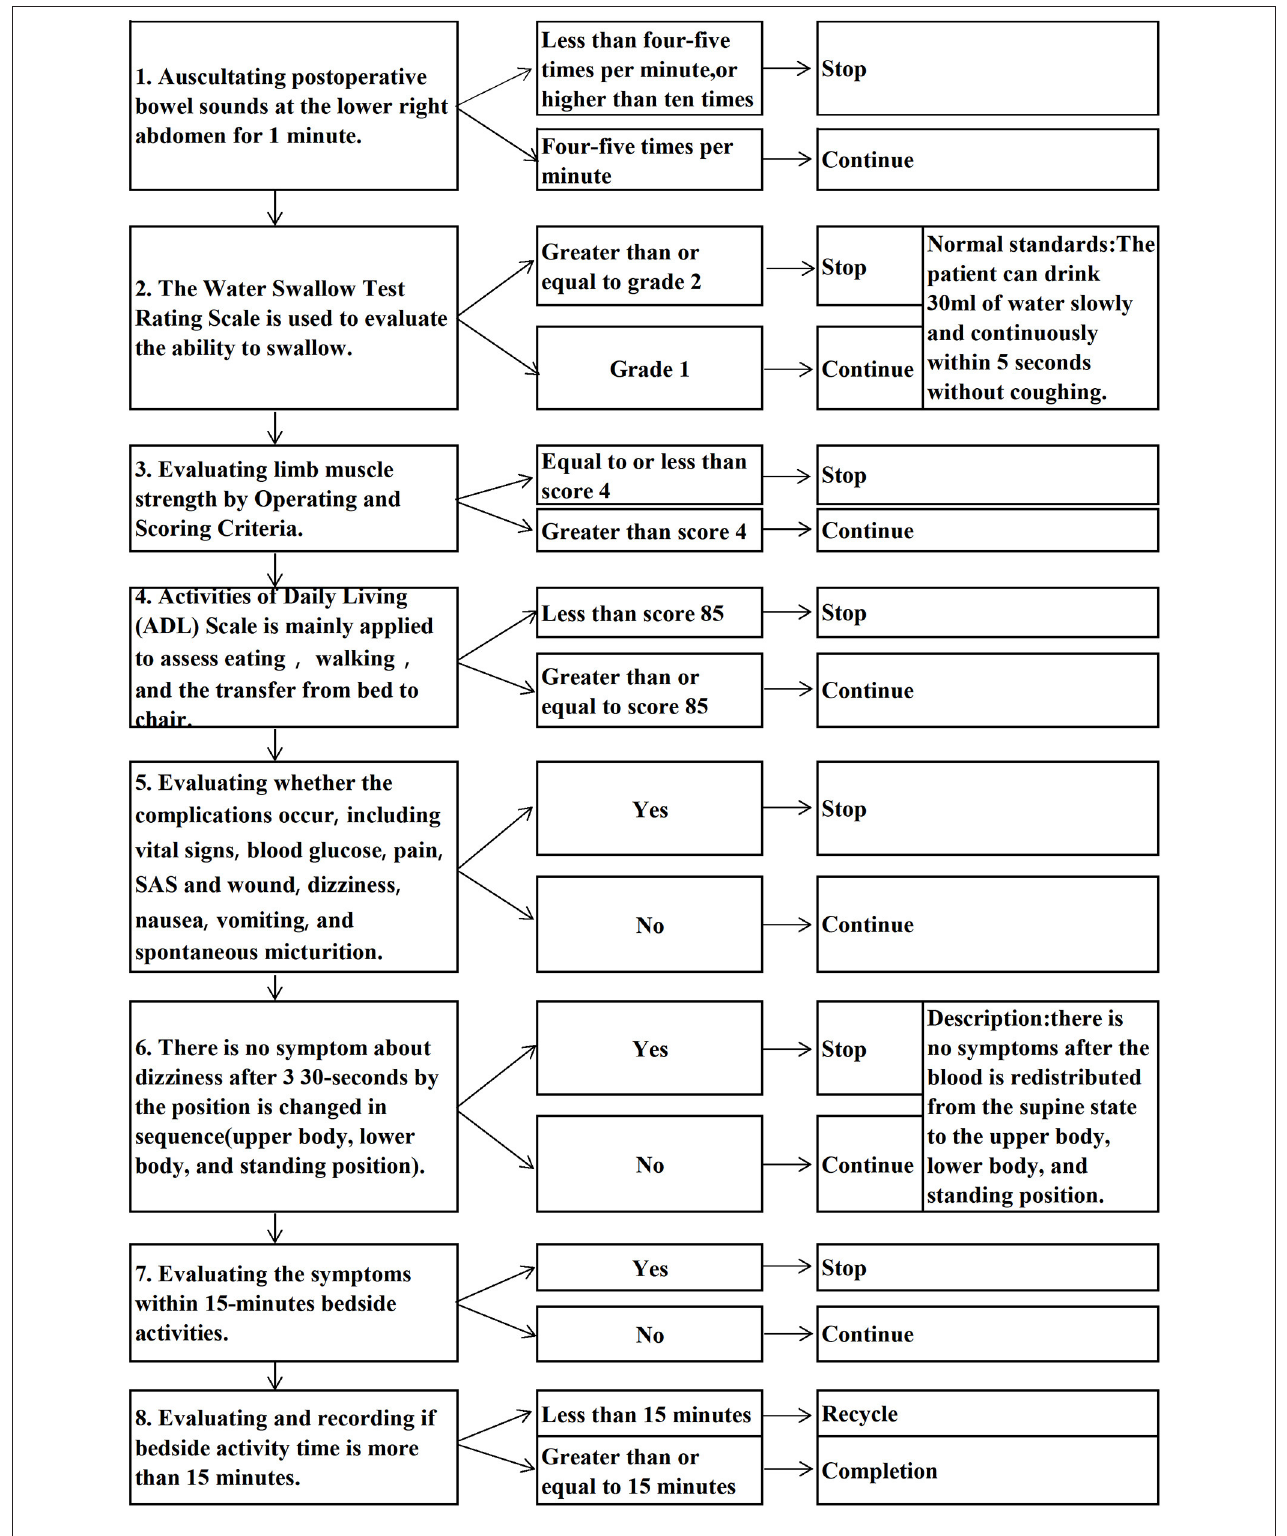
FIGURE 2 | The workflow of the first